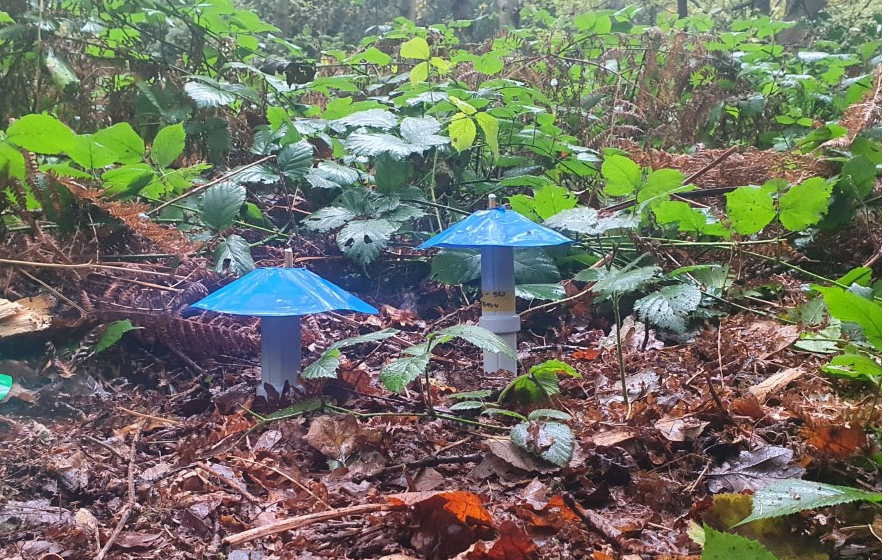
Figure 7. CO 2 probes driven to different soil depths.